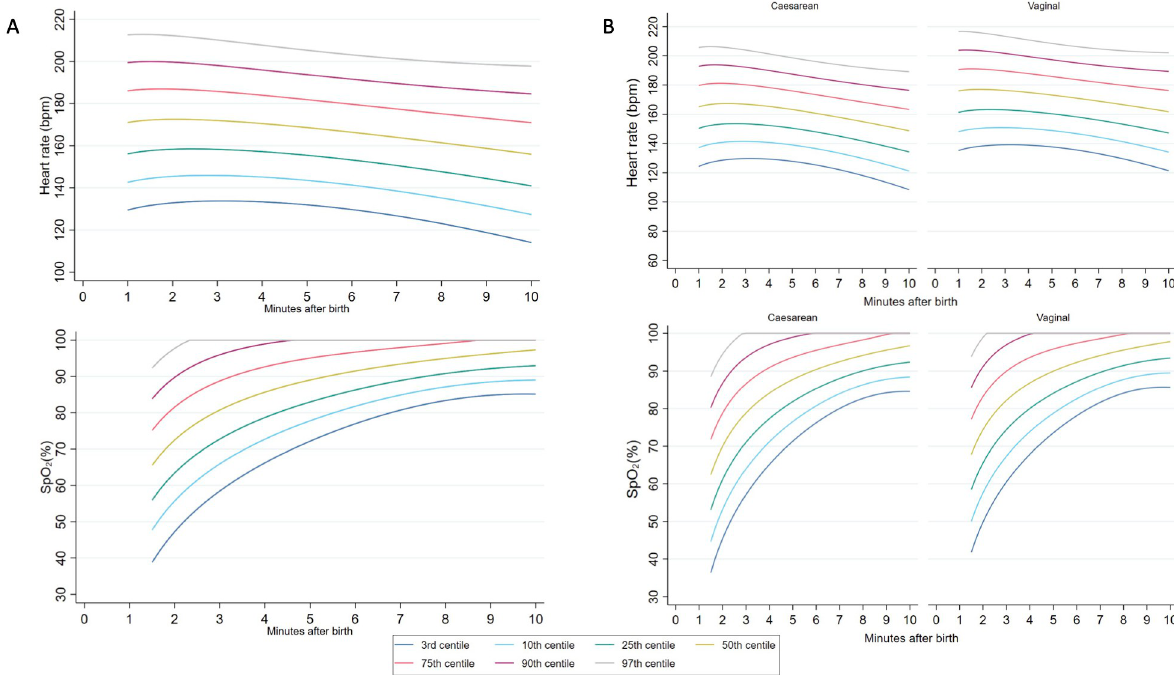
Fig 3. (A) Third, 10th, 25th, 50th, 75th, 90th, and 97th heart rate and preductal arterial oxygen saturation (SpO 2 ) percentiles for all infants � 35 weeks’ gestational age with no respiratory support after birth. (B) Heart rate and SpO 2 percentiles stratified by mode of birth.